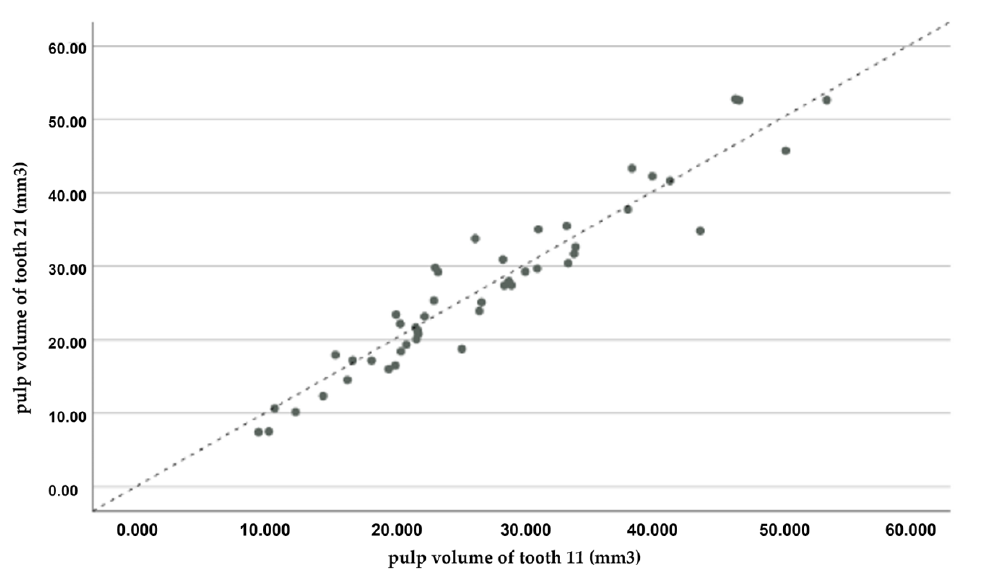
Figure 3. Comparison of the values for the pulp volume of the upper central